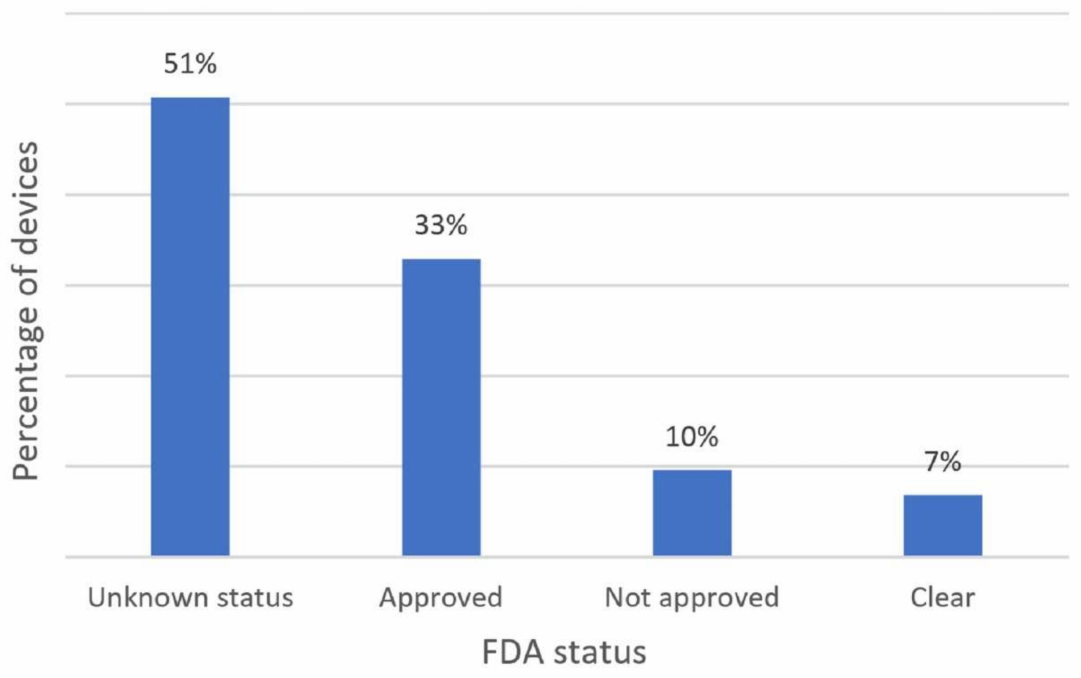
Figure 5. FDA Approval Status of Commercial Wearables for Engagement